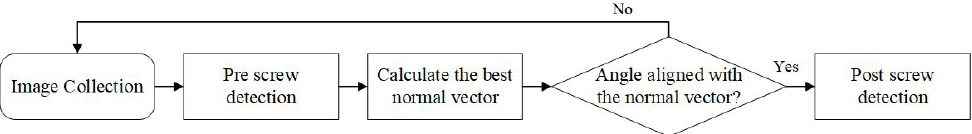
Figure 4. Flowchart of the robot arm adaptive adjustment algorithm.